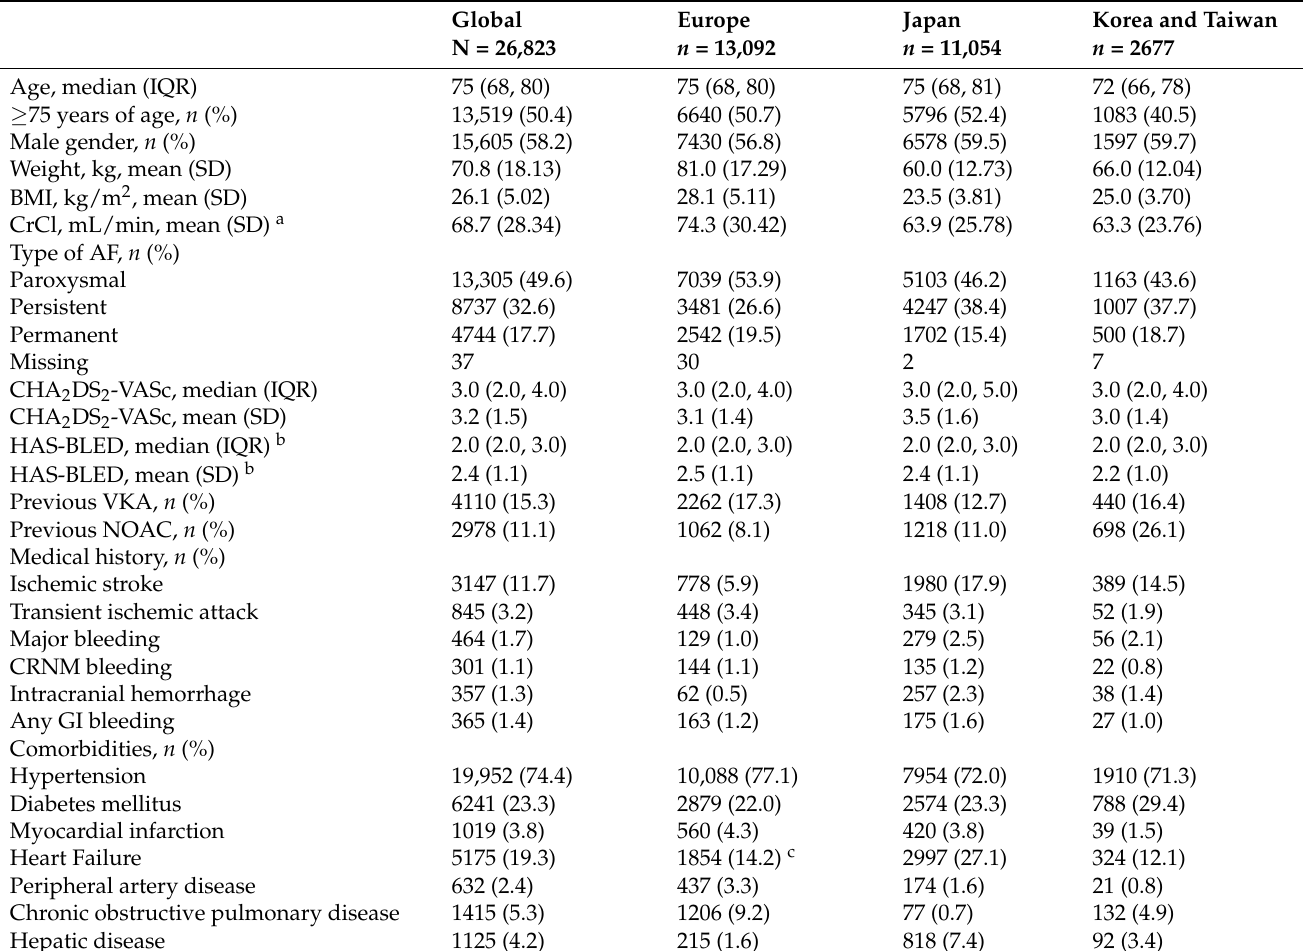
Table 1. Baseline demographics and clinical